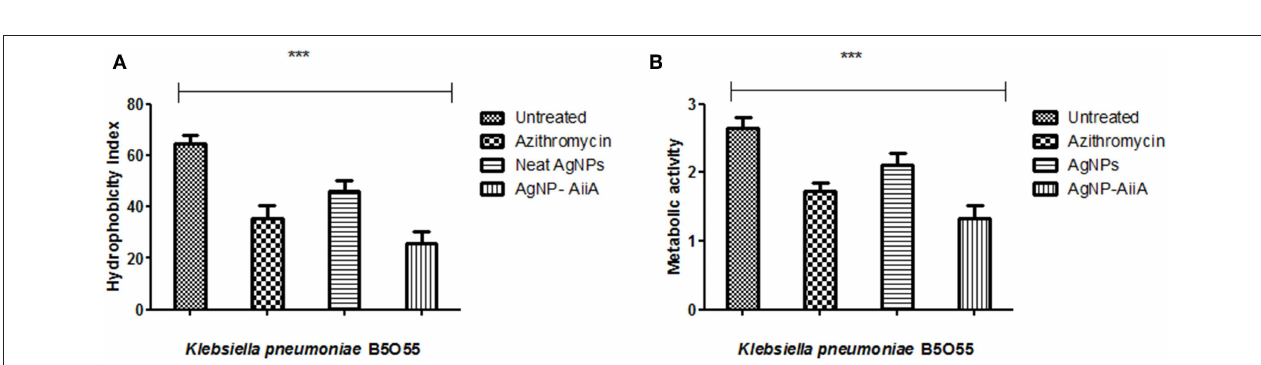
FIGURE 9 | Bar graph showing (A) the reduction in hydrophobicity index of K. pneumoniae upon treatment with sub-optimal concentration of azithromycin, neat AgNPs and AgNP-AiiA complex. One way ANOVA proved the result of events as highly significant ( P < 0.001) (B) the reduction in the metabolic activity of K. pneumonaie upon administration of sub-optimal concentration of azithromycin, neat AgNPs and AgNP-AiiA complex ( P -value 0.0023, *** p < 0.001).